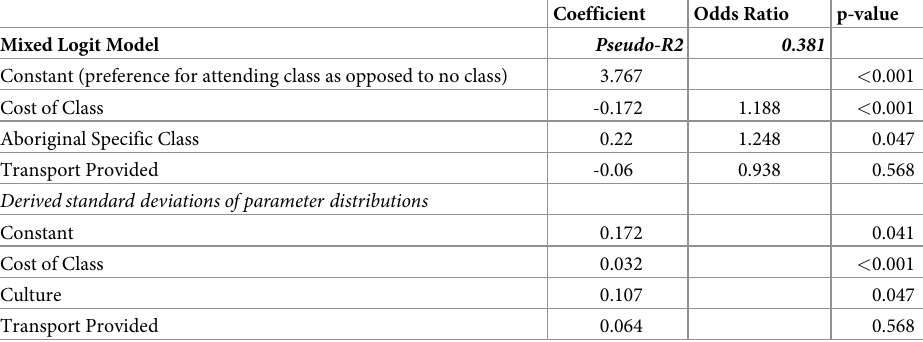
Table 2. Discrete choice experiment modeling